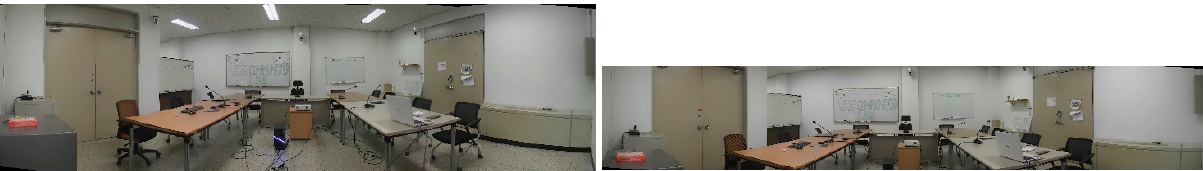
Appl. Sci. 2021 , 11 , 11019 Figure 10. Panoramas from side: left (5800 × 1600 = 180° × 56°) and right (5800 × 1000 = 180° × 36°).